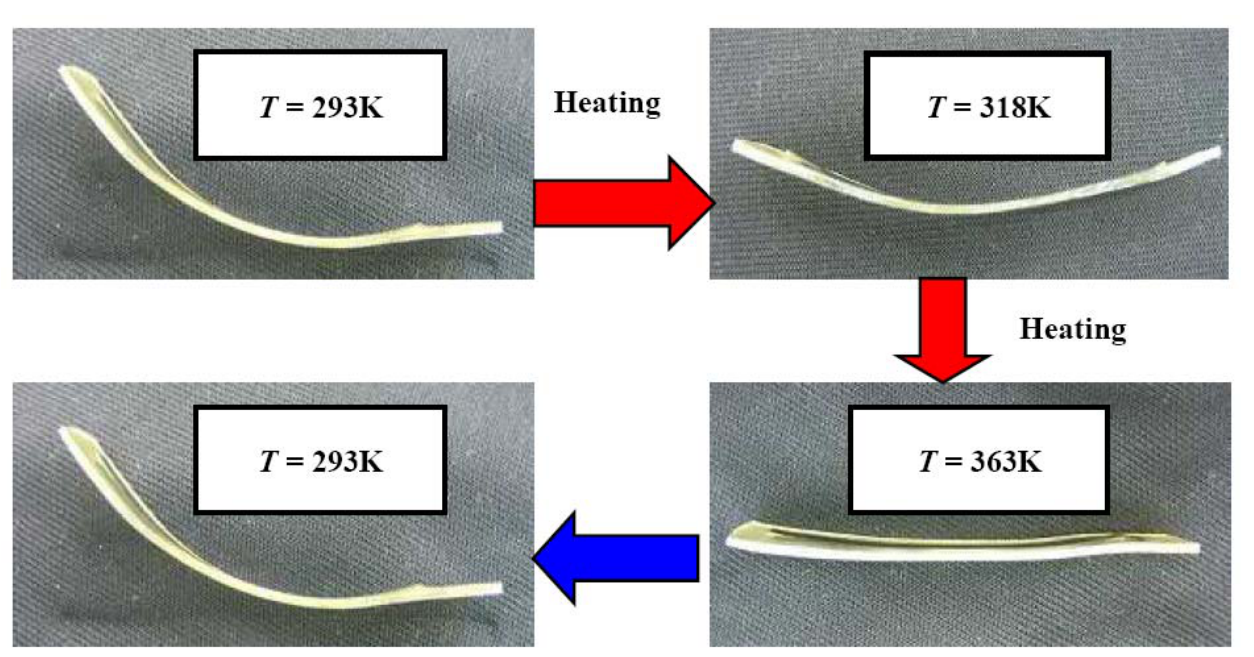
Figure 6. Photographs of the two-way bending deformation of the SMC belt during heating and